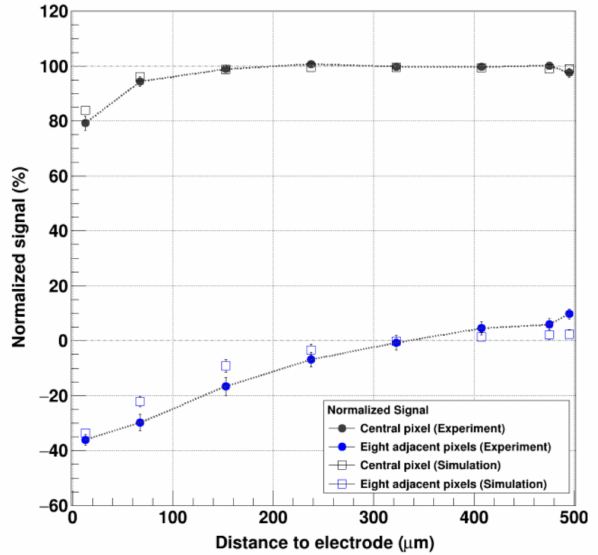
Figure 12. Comparison of the experimental and simulated data of the angle-on measurement: (Black solid indicator: experimental data/black square: simulated data) Signal in the central pixel of a 3 × 3 cluster as function of the absorption distance from the electrode. (Blue solid indicator: experimental data/blue square: simulated data) Signal in the eight adjacent